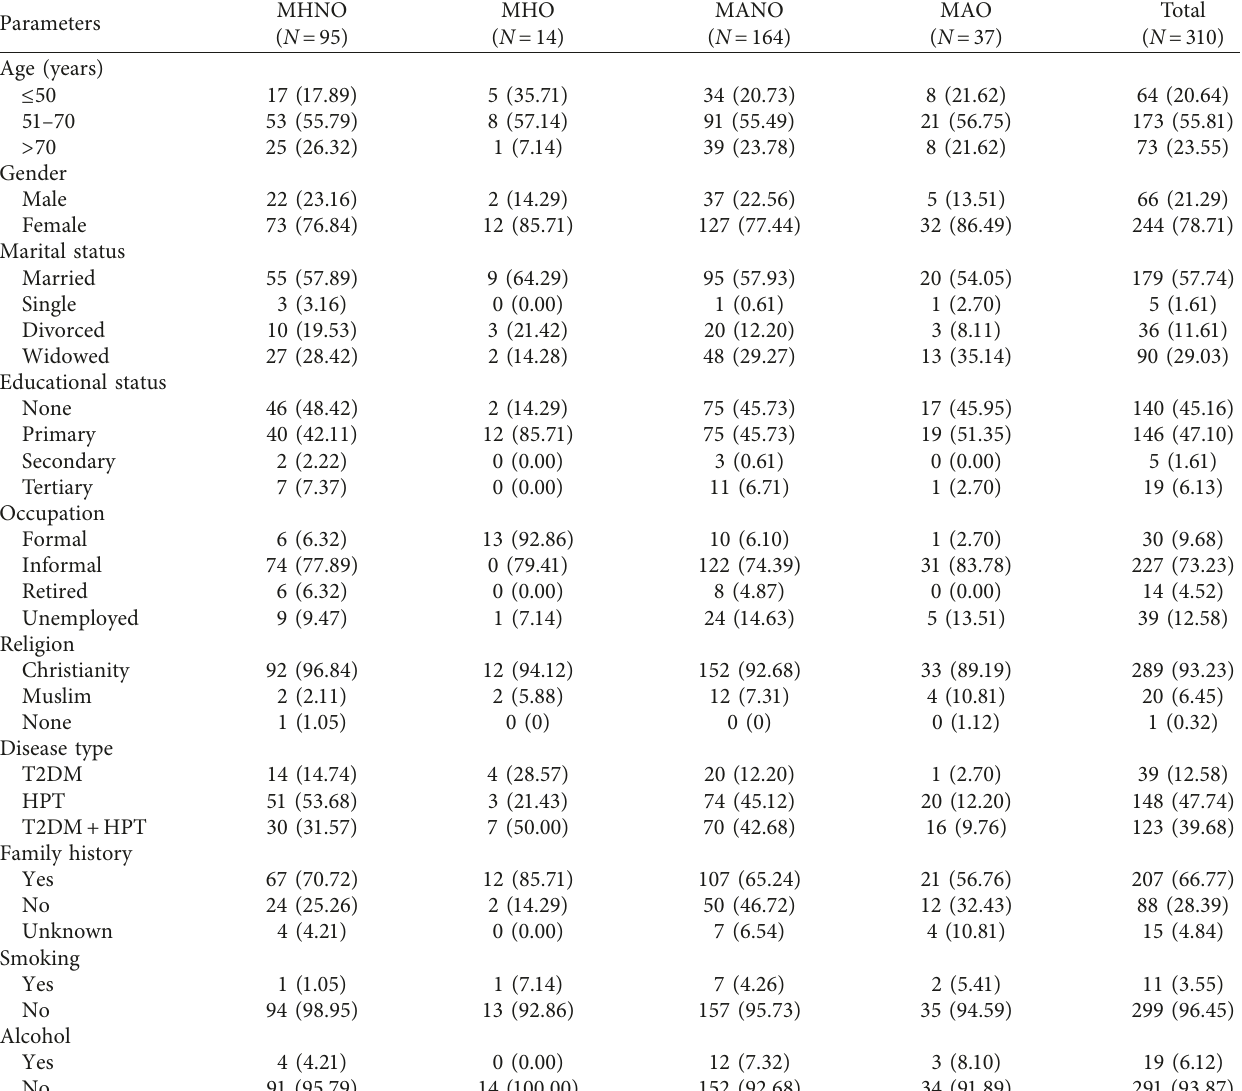
Table 1: Prevalence and distribution of the various sociodemographic parameters among the study participants stratified by obesity